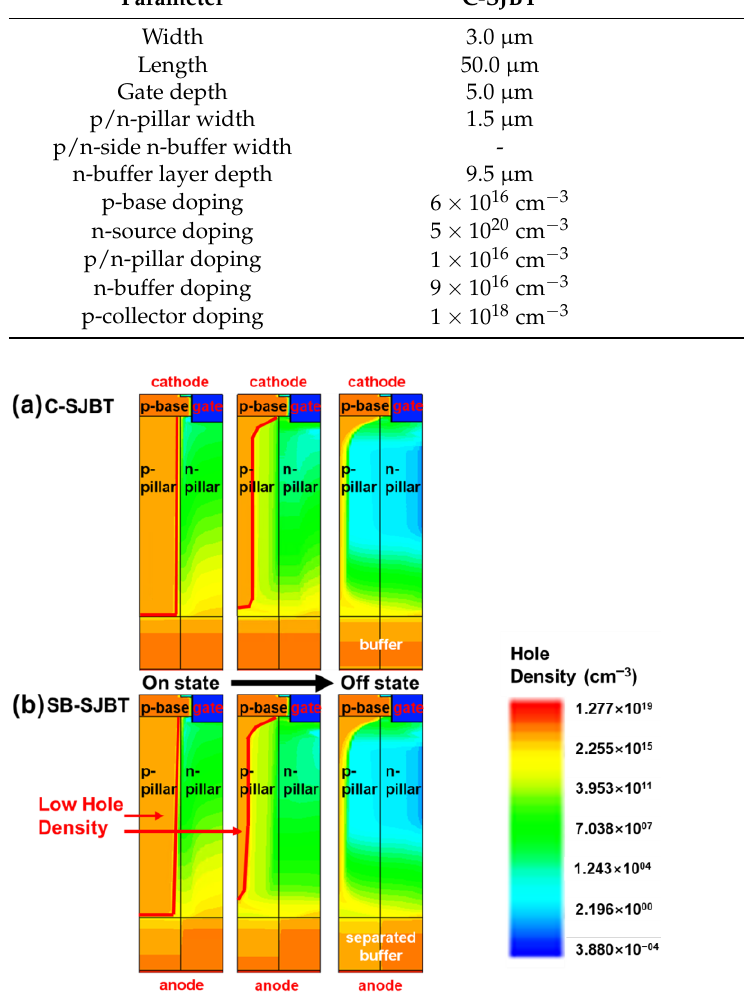
Figure 2. Comparison of hole density between ( a ) C-SJBT and ( b ) SB-SJBT by state. Fewer holes in SB-SJBT are injected into the p-pillar than in C-SJBT, and extraction is relatively fast. Table 1. Device parameters for the